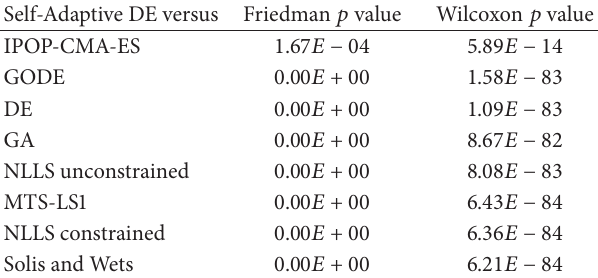
Table 6: Raw 𝑝 values (IPOP-CMA-ES is the control algorithm) for the 4-by-4 degree polynomial rational function.